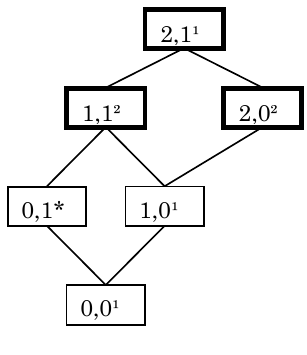
Fig. 6. Evaluation of attribute {a} based on reduct {b,d}